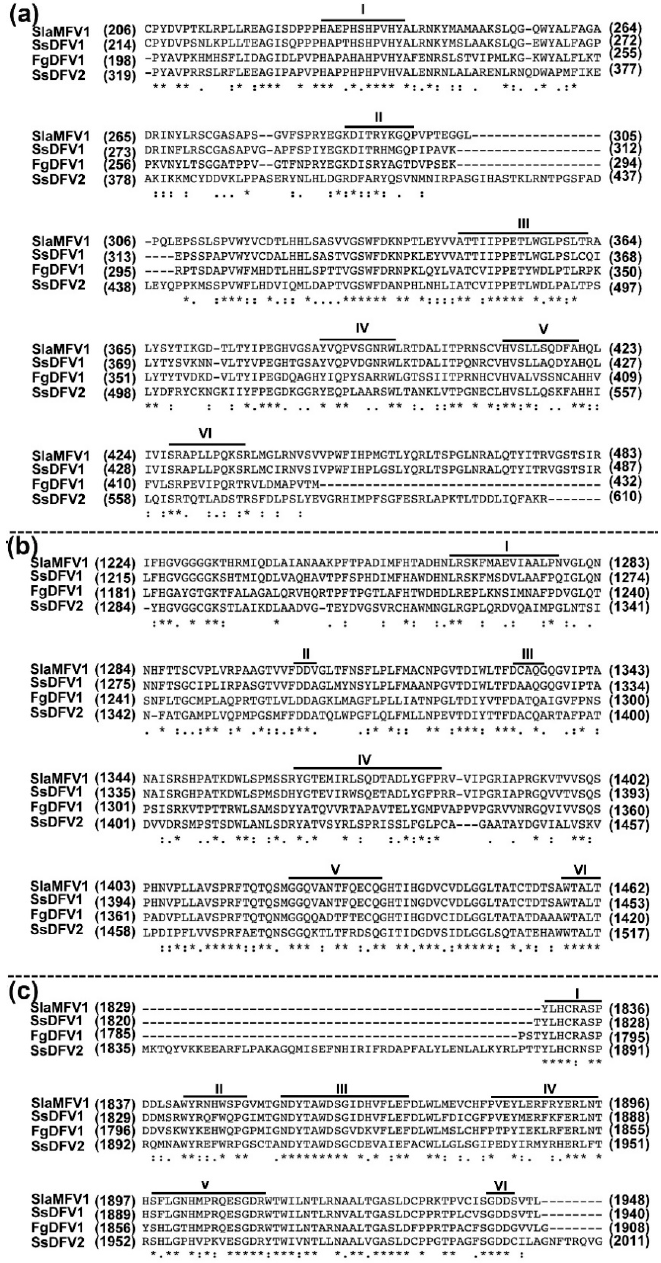
Figure 4. Multiple alignments of the three conserved domains of SsDFV2 and corresponding regions in reference members of the order Tymovirales. ( a ) methyltransferase; ( b ) helicase; ( c ) RdRp. Motif positions are indicated by lines above the sequences numbered from I to VI. Identical residues are indicated by asterisks, and conserved and semi-conserved amino acid residues by colons and dots, respectively. Numbers in brackets correspond to the number of amino acid residues separating the motifs. Abbreviations of virus names and sequence accession numbers are as indicated in Table 2.